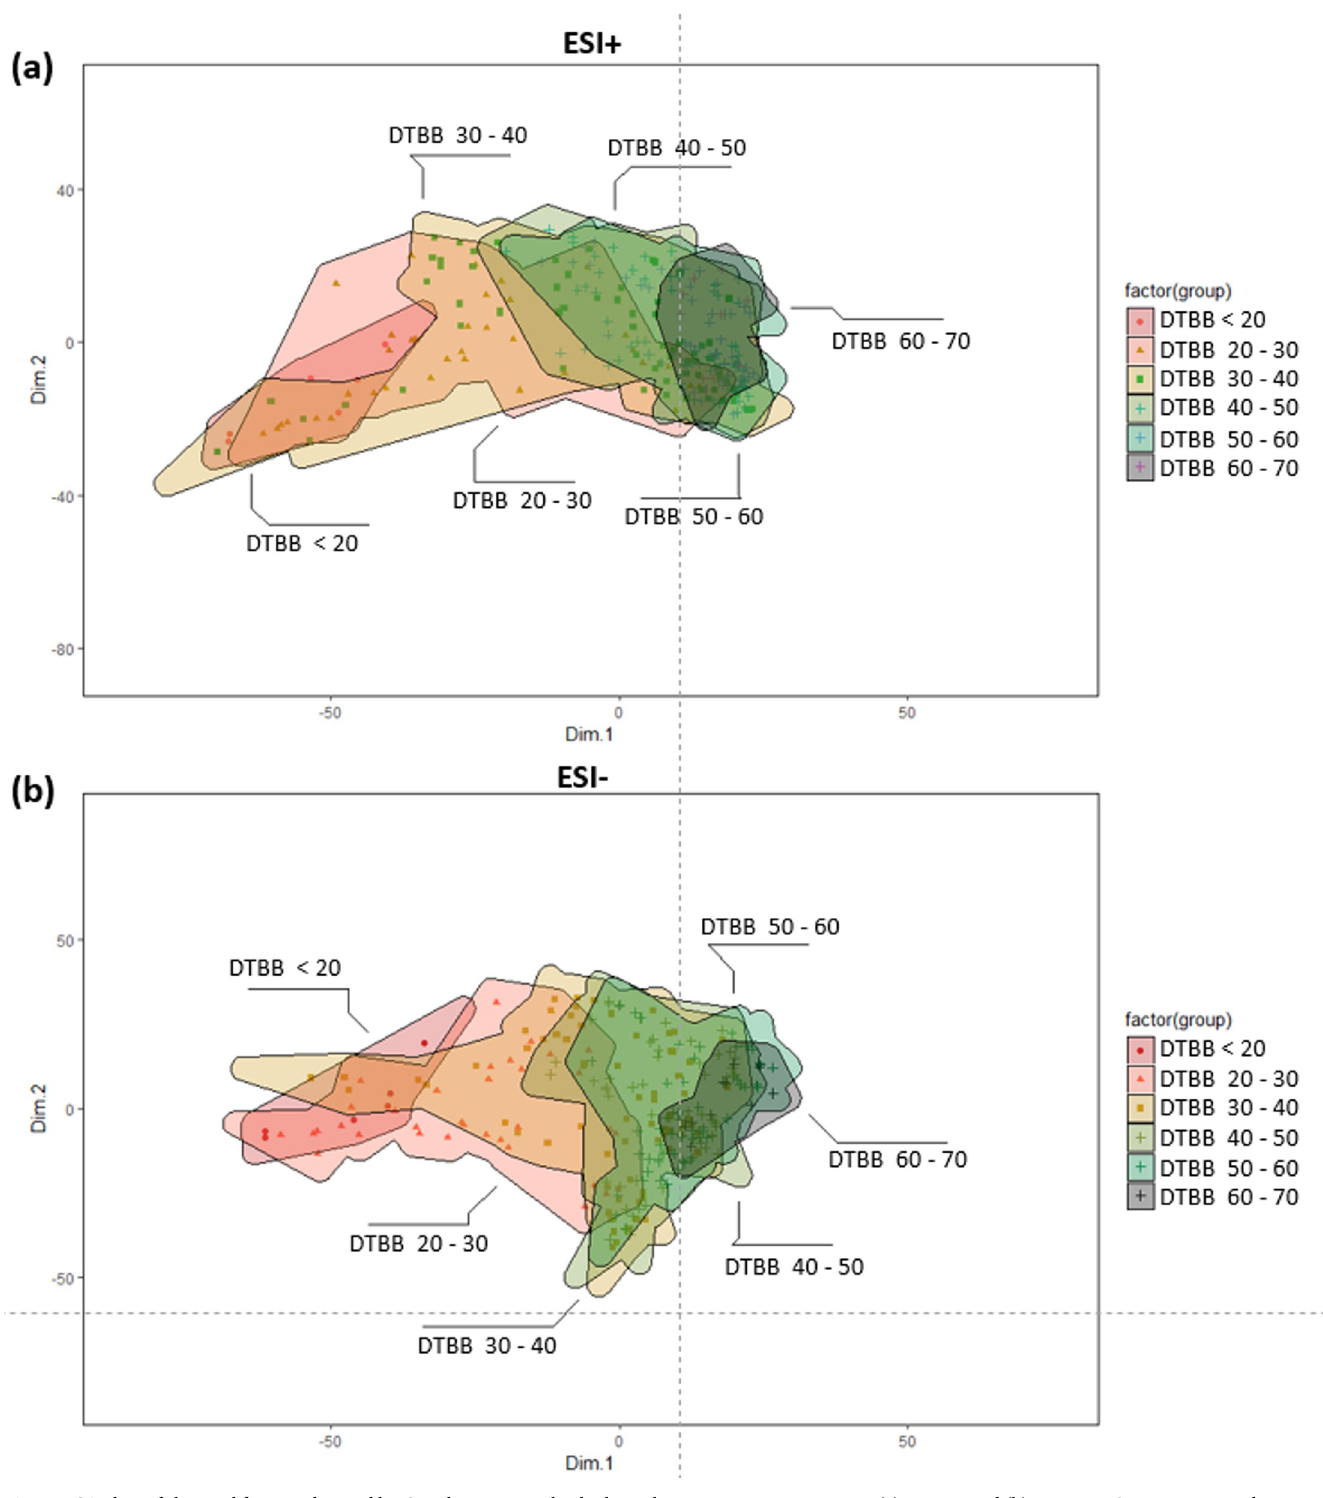
Fig 2. PCA plots of chemical features detected by C18 chromatography, high resolution mass spectrometry in (a) positive and (b) negative ESI ionization modes. Samples were organized by DTBB, showing co-clustering by DTBB > 40, followed by a shift with the later date samples.